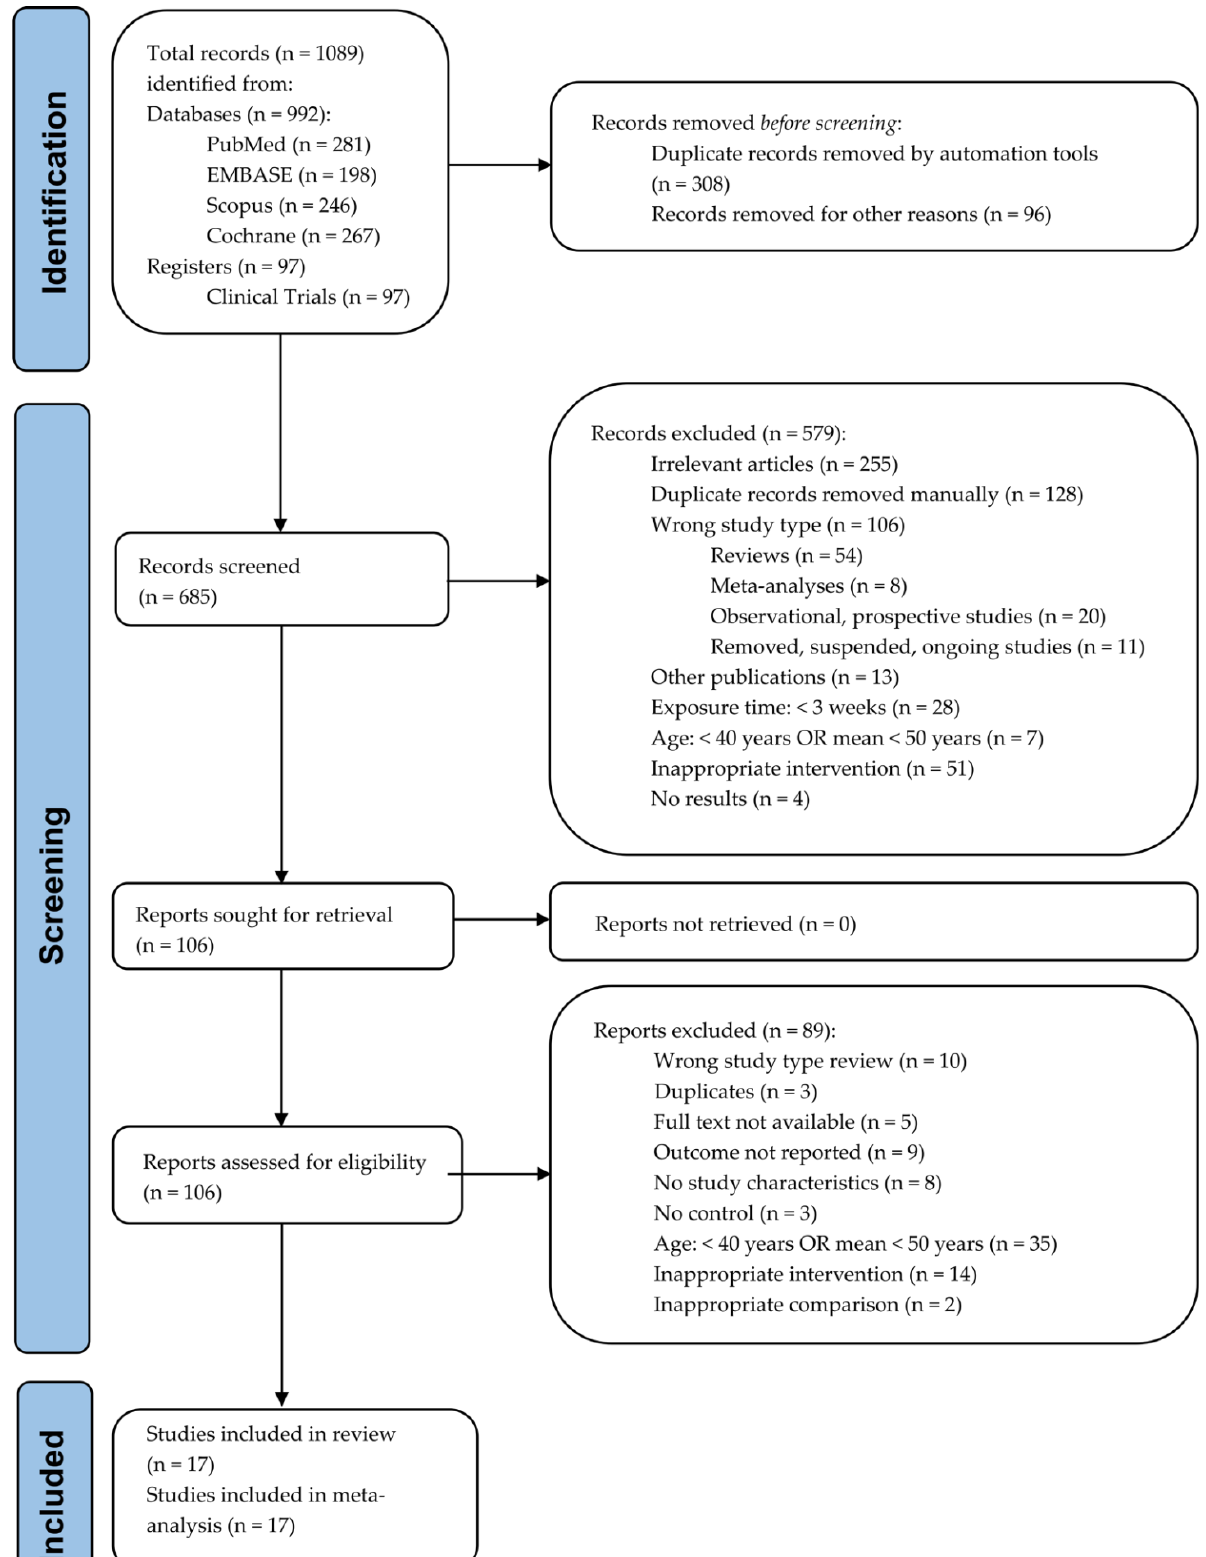
Figure 1. PRISMA flow diagram of study selection.